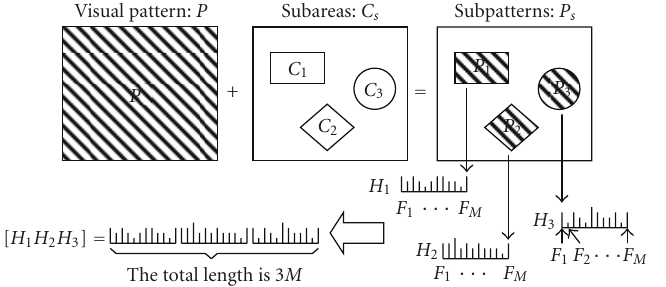
Figure 4: The pattern P is covered by the area C . The C is composed of three subareas: C 1 , C 2 , and C 3 . Single histogram is calculated from each subarea. Each histogram contains M bins, which is corresponding to M features from the feature set F . Finally, the three histograms are concatenated in a form of [ H 1 H 2 H 3 ], which is description of pattern P